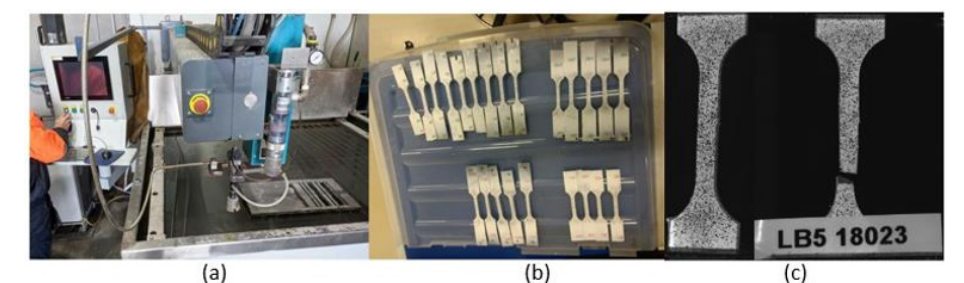
Fig. 4. (a) Water jet cutting of the samples, (b) dog-bone samples, (c) speckled sample for DIC